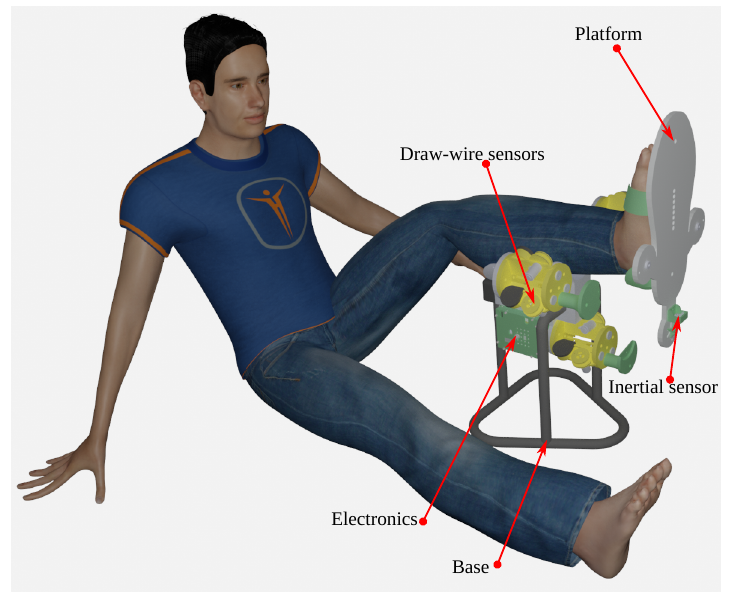
Figure 23. Rendered image with a 175 cm height